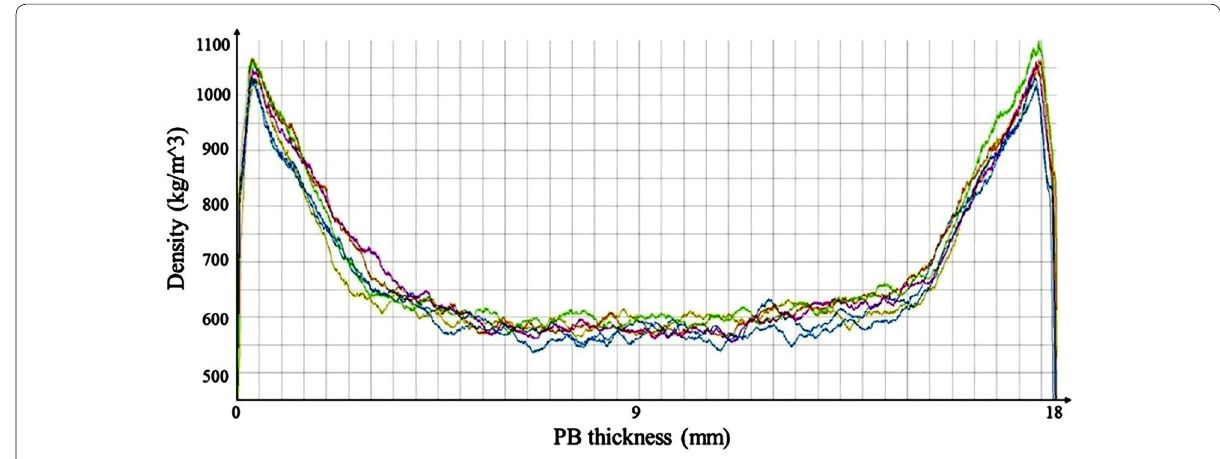
Fig.9 Results of VPD tests for IB test specimens by VPD analyzer